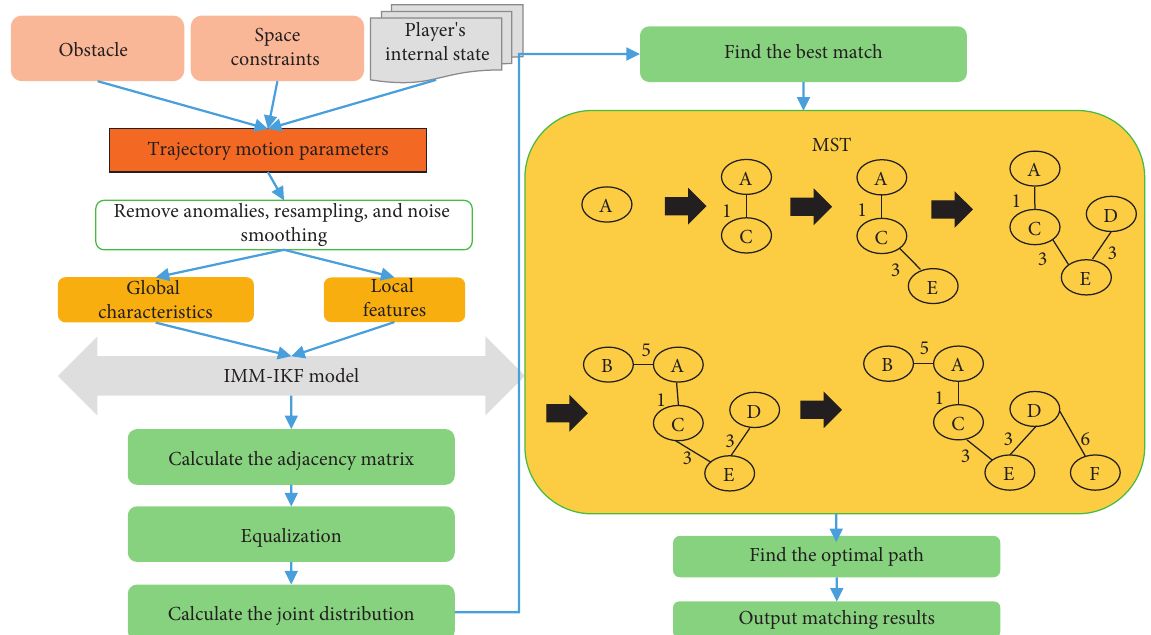
Figure 3: Process diagram for constructing the